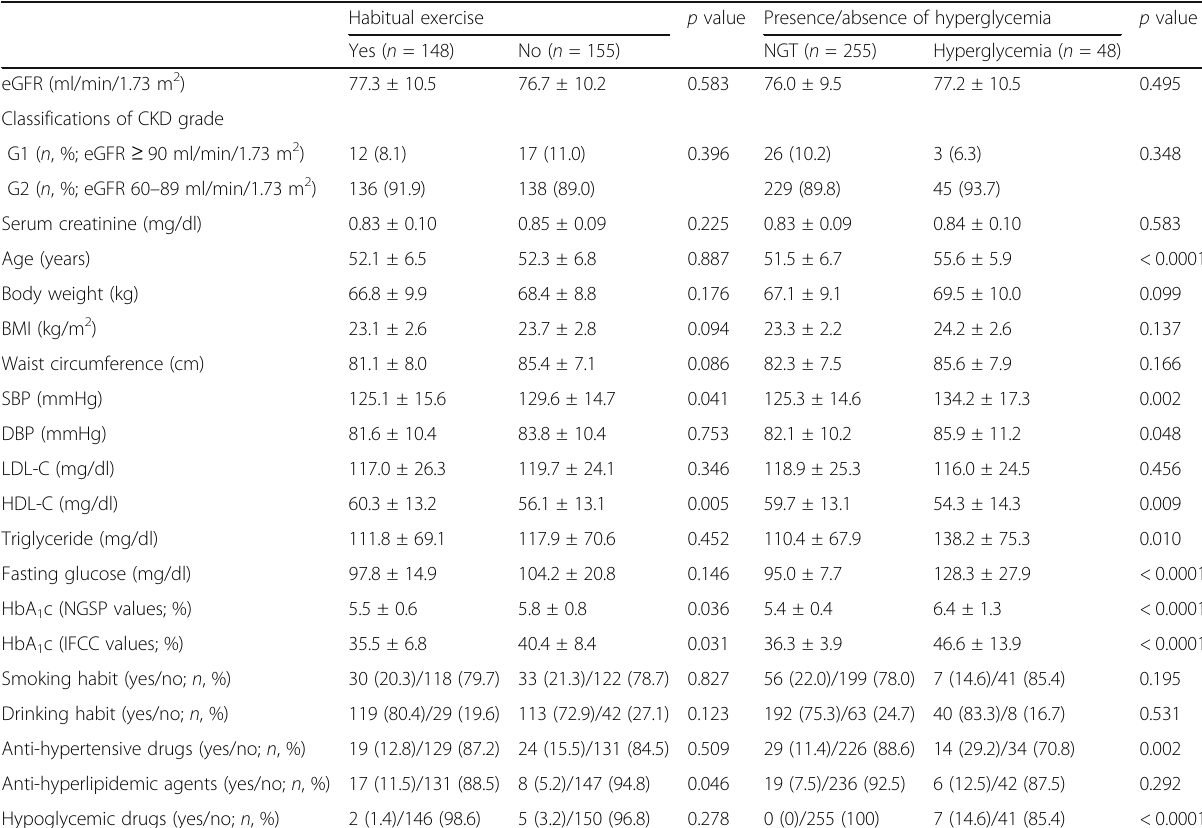
Table 2 The baseline characteristics in subjects with and without habitual exercise and hyperglycemia Habitual exercise p value Presence/absence of